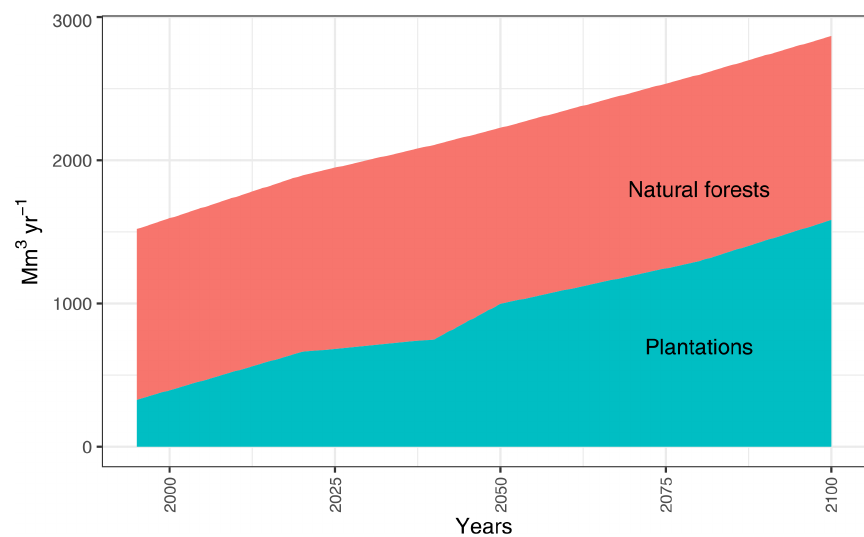
Figure 14. Global industrial roundwood production by source for the forestry scenario (1995–2100; in Mm 3 yr − 1 ).